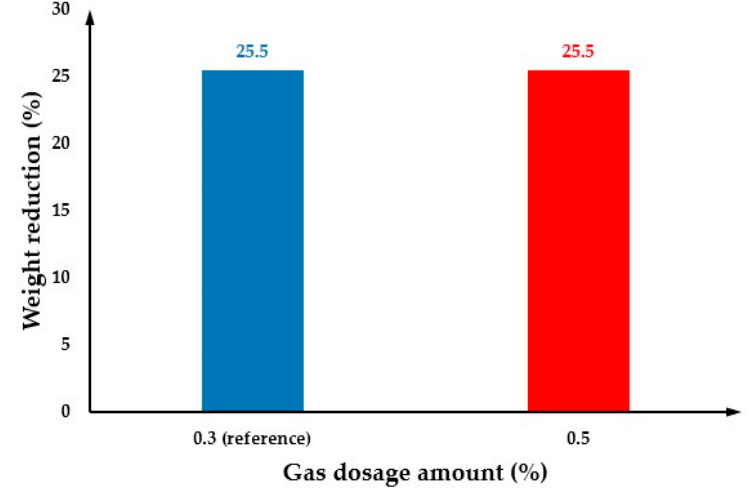
Figure 11. Cross-section variation in cell size as a function of gas dosage amount.